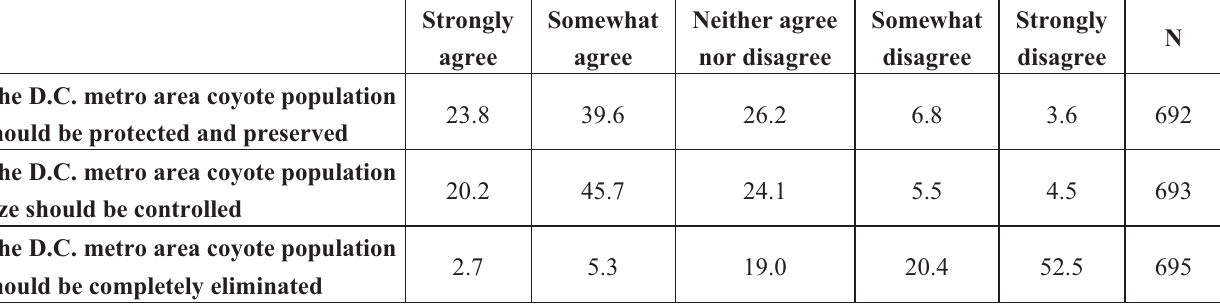
Table 3. Attitudes towards coyote management. Given in